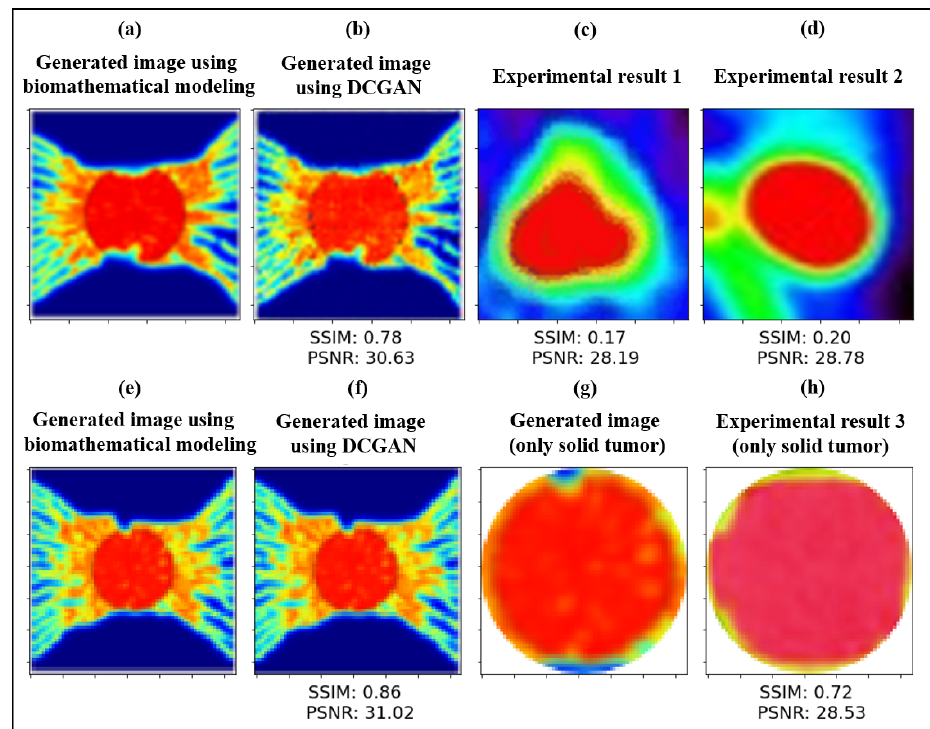
Figure 6. Quantitative and qualitative comparisons of the synthetic and clinical 18F-FDG PET radiotracer images of solid tumors at different stages of progression and angiogenesis. ( a ) A synthetic PET image generated by biomathematical modeling for a tumor with 2.4 cm diameter is compared with ( b ) an augmented PET image generated using the DCGAN model, and ( c , d ) two clinical PET images [58,57]. Comparison between ( e ) a synthetic PET image generated by biomathematical mod- eling without implementing the DCGAN for a 2cm tumor and ( f ) another augmented PET image generated using DCGAN. ( g ) The solid tumor in panel ( f ) is also compared with ( h ) another image of solid tumor taken experimentally [59], showing excellent agreement in terms of quantitative as- sessments with SSIM and PSNR values and qualitative comparison of radiotracer uptake in solid tumor. SSIM and PSNR values are defined according to Equations (16) and ( 17), respectively. Im- ages in panels ( c , d , h ) are adopted and printed with permission from [57–59]. Copyright 2022.